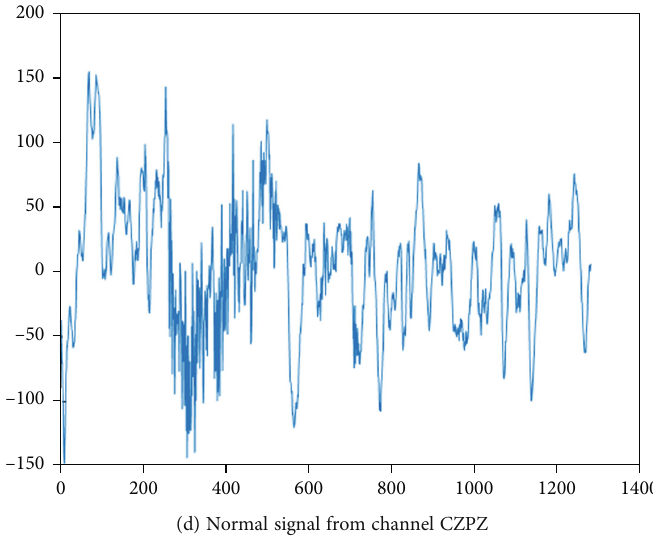
Figure 6: Normal signal and abnormal signal from nonepileptic Table 3: Signi fi cance analysis of normal signal and abnormal signal.